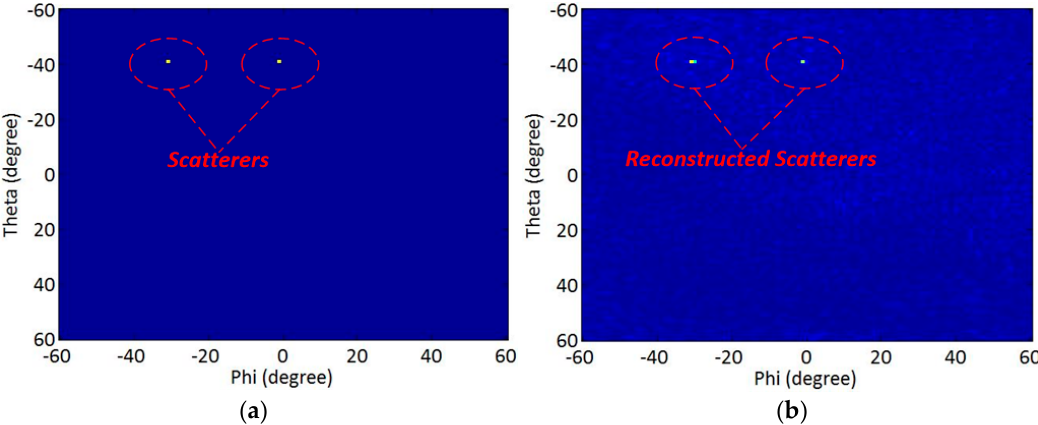
Figure 9. Target scenes: ( a ) true target scene consisting of two point scatterers; ( b ) the same scene reconstructed by the fabricated MAA.